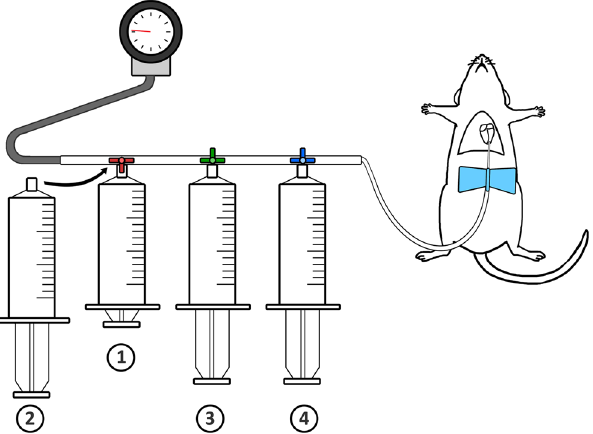
Figure 1. Schematic of ROX SE perfusion in mice. In the ROX SE perfusion technique, the following solutions are perfused in sequence: 1) 10 mL of 10 mM glucose-PBS-Heparin, 2) 20 mL of 10 mM glucose-PBS, 3) 20 mL of 20 μ M ROX SE solution, and 4) 20 mL of 4% paraformaldehyde. Perfusion pressures are maintained at 80 ± 5 mm Hg as indicated by the attached sphygmomanometer.